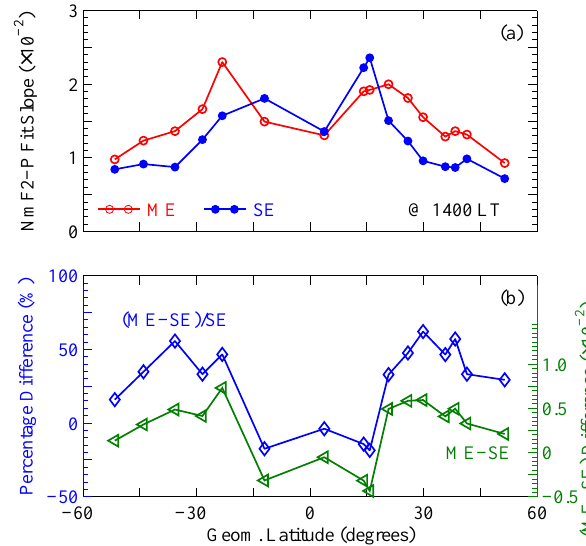
Fig. 3. (a) Latitudinal variations of the linear fit slope of Nm F2 with P (fitting for P < 140, see Fig. 2) in the East-Asia/Australia sector. (b) The percentage difference and the (ME-SE) difference of the linear fit slope.